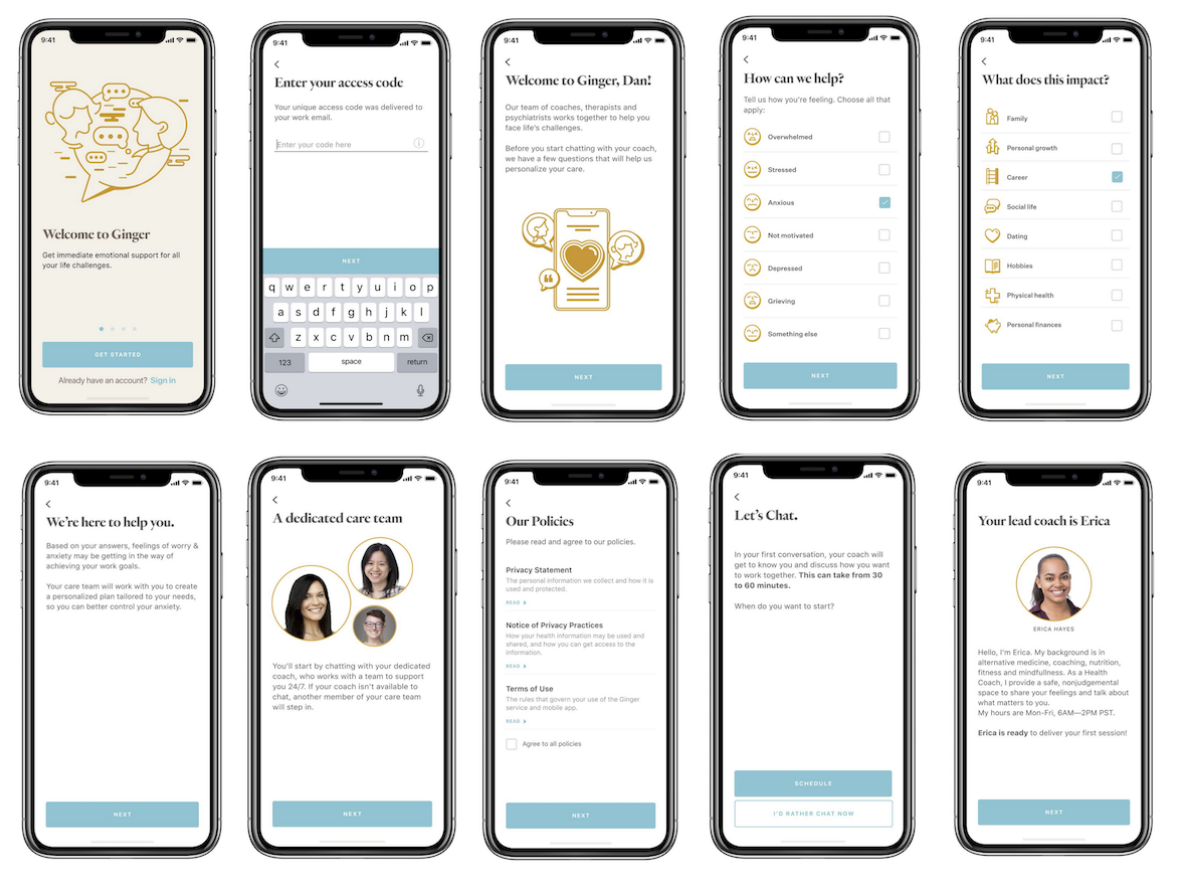
Figure 1. Ginger mobile app onboarding